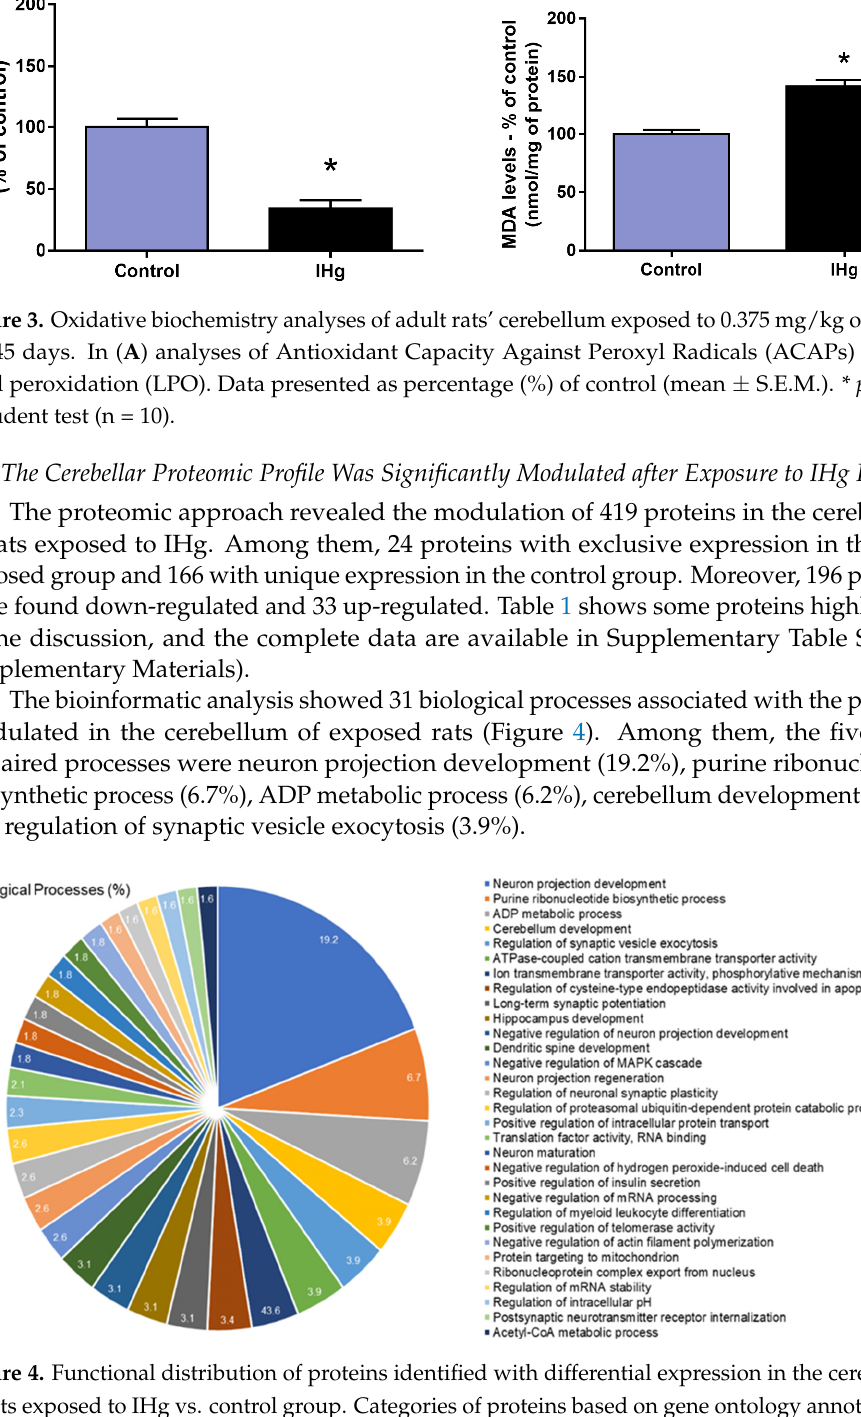
Figure 4. Functional distribution of proteins identified with differential expression in the cerebellum of rats exposed to IHg vs. control group. Categories of proteins based on gene ontology annotation of biological process. Terms significant (KappaScore = 0.4) and distribution according to the percentage of the number of genes. UNIPROT provided proteins access number. The gene ontology was evaluated according to the ClueGo ® plugin of Cytoscape ® software